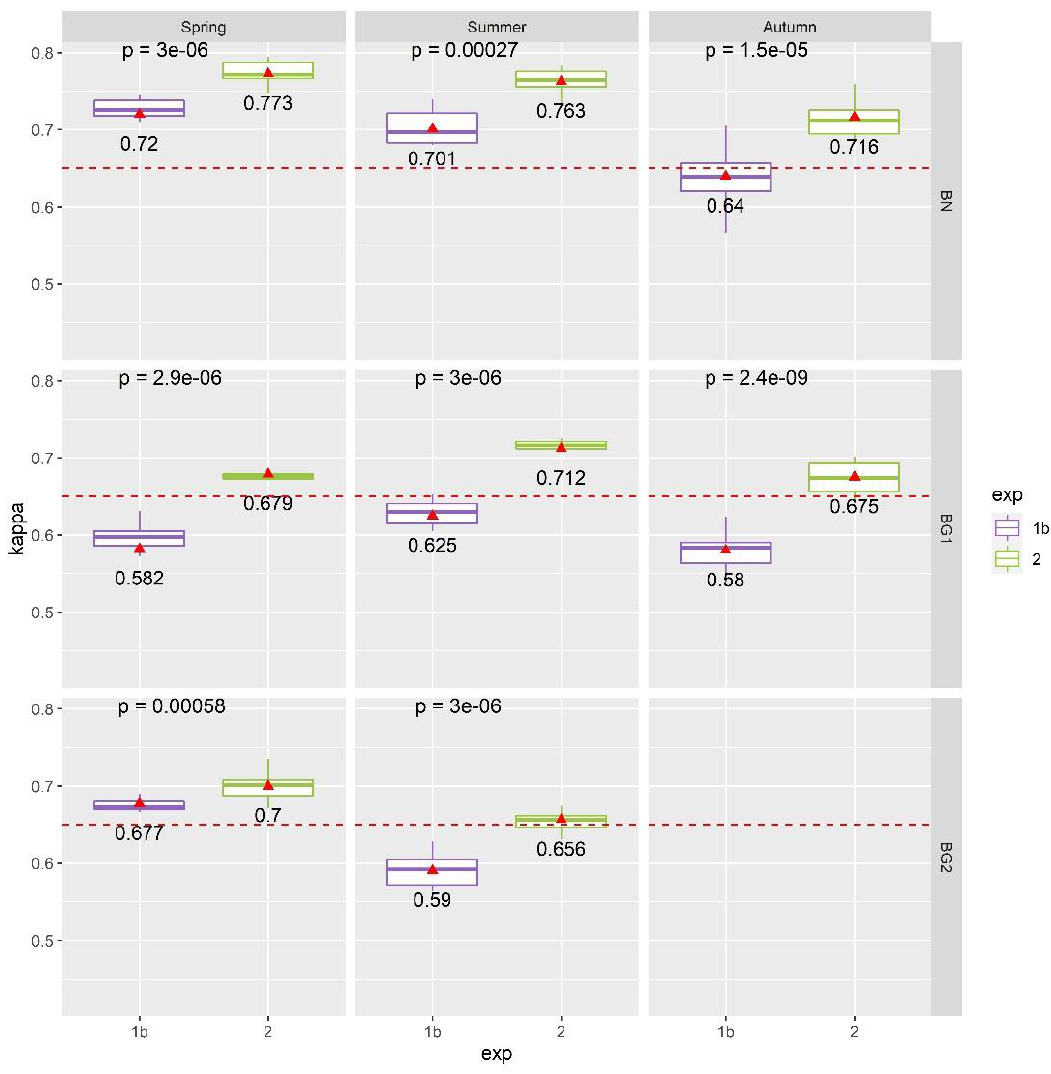
Figure 9. Comparison of K accuracies obtained by classifying the MNF components alone (Exp. 1b) and MNF plus the optimal selections of LiDAR products and SI (Exp. 2). p-values resulting from the Wilcoxon test comparisons are displayed. Red triangles represent the mean K values (also written). Boxplots show the median, the lower and upper hinges corresponding to the first and third quartiles; the upper and the lower whiskers are the 1.5 · interquartile range. Red dotted lines represent a confidence level of K = 0.65.